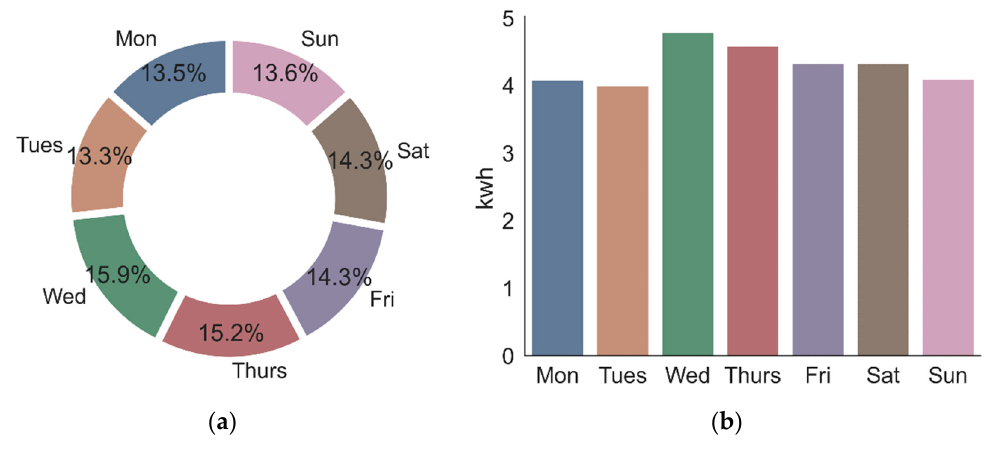
Figure 12. SARIMA dashboard forecasting: energy consumption hourly forecasting. 3.3.2. RNN/LSTM Results Alternatively, to the SARIMA approach, an RNN approach has been adopted for energy forecasting. To further improve the performance of the SimpleRNN mode, LSTM networks have been used. Hyperparameter tuning has been performed, and the param ‐ eters used were time lag = 24, layer depth = 64, epochs = 500. Figure 13 depicts the per ‐ formance comparison of measured and forecasted values on 7 days test data, while uti ‐ lizing SARIMA, RNN and LSTM approaches. Figure 14 is the dashboard, depicting one ‐ week ahead load forecast utilizing LSTM as the preferred approach, based on the best reported performance measures. Some details about the LSTM testing environment are shown in Appendix A.